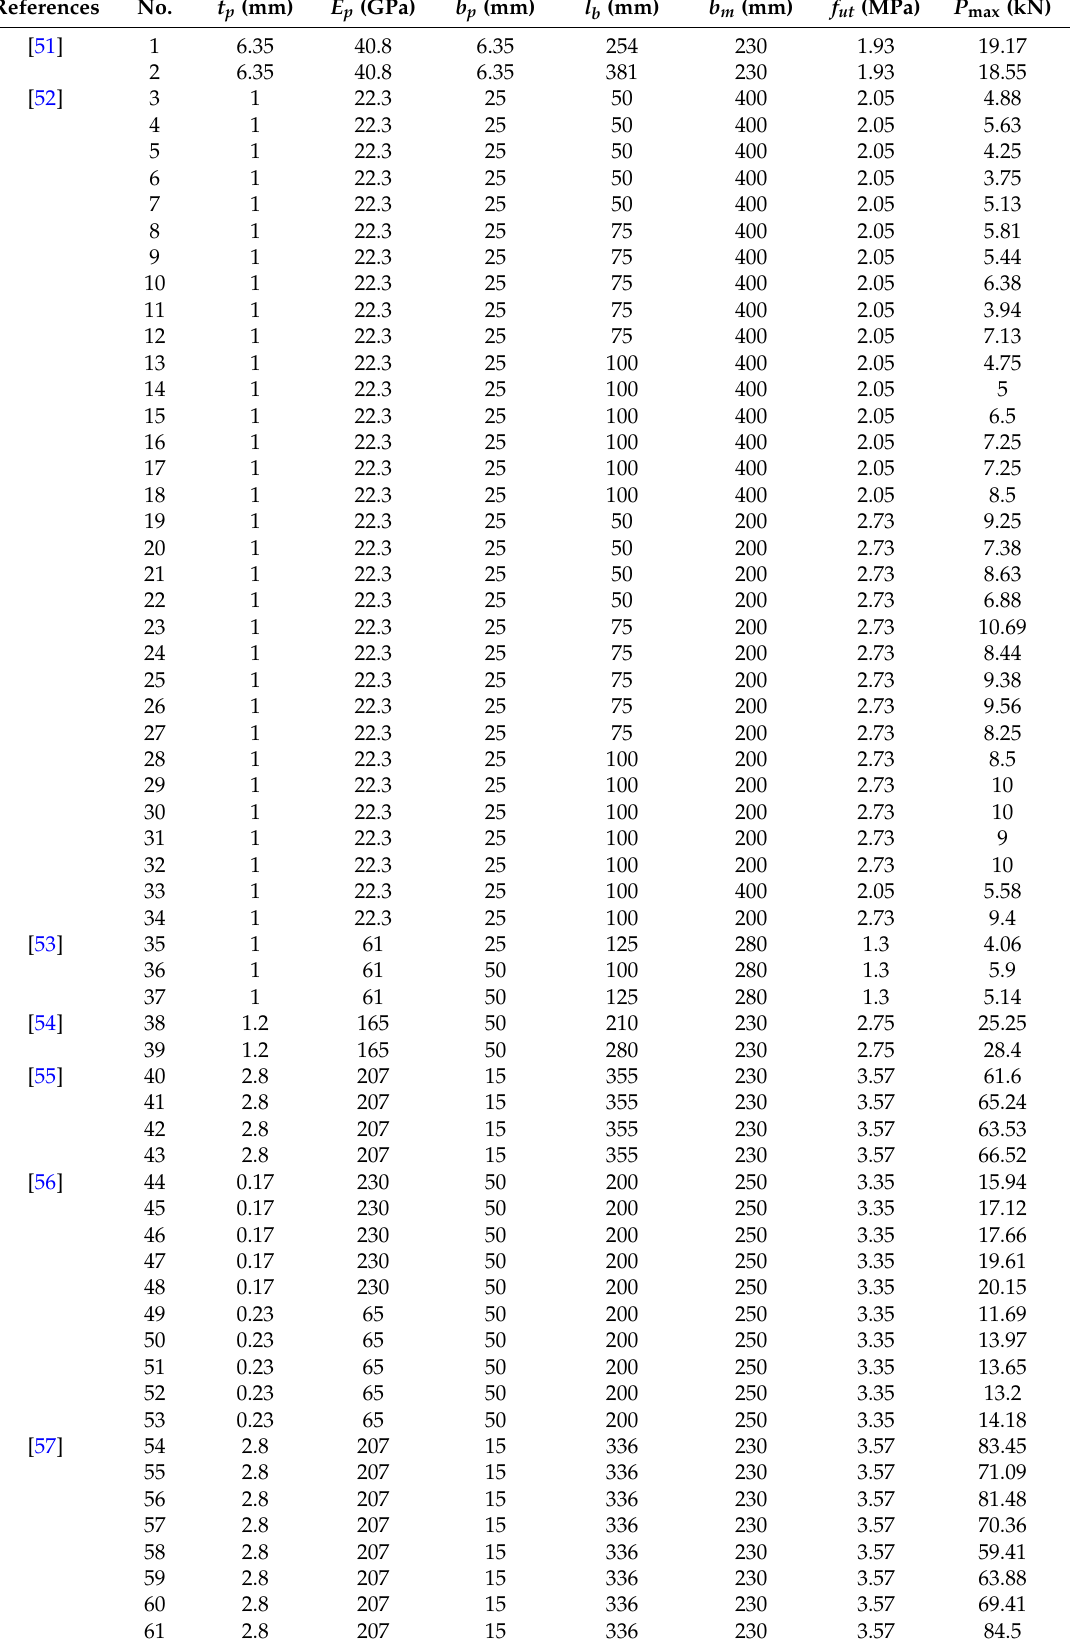
Table 2. Database for FRP-reinforced masonry members (from Kashyap et al.